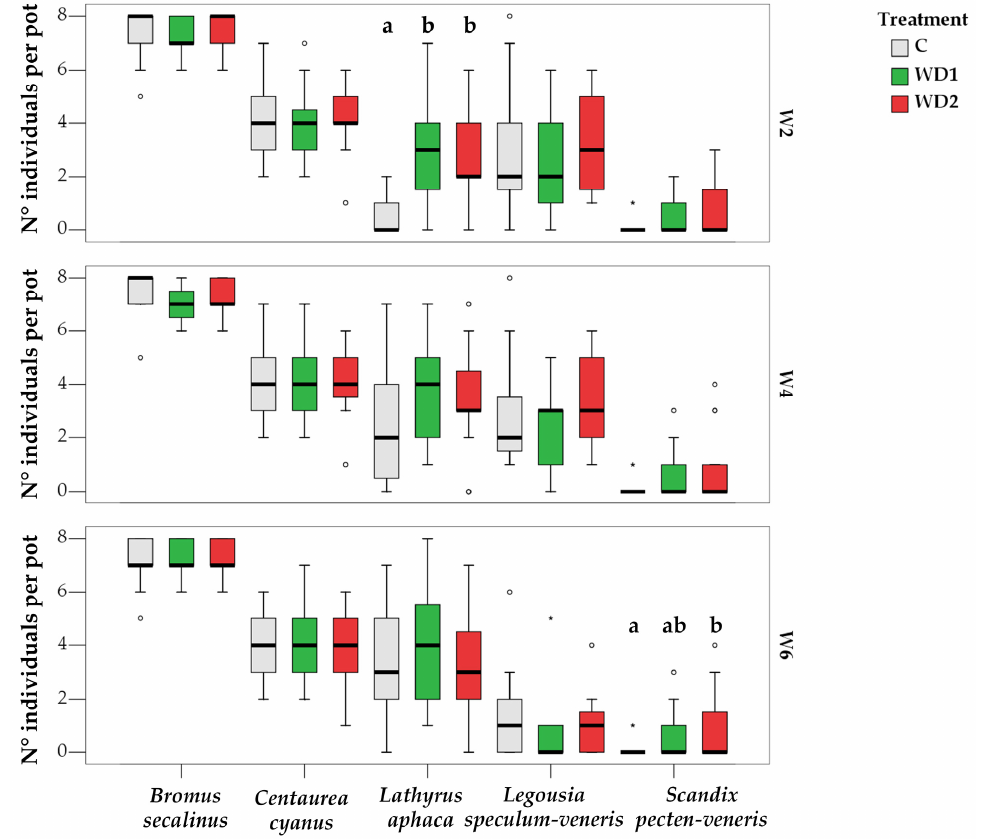
Figure 4. Boxplots showing the total number of individuals of each species per pot per treatment (C = 0% wood distillate; WD1 = 0.2% wood distillate; WD2 = 0.5% wood distillate) at week 2 (W2), week 4 (W4), and week 6 (W6). Different letters indicate statistically significant differences between treatments for each species ( α = 0.05). ◦ = outlier; * = extreme value. Table 3. Results of the PERMANOVA analyses on community composition with the dry weight of each species as an abundance measure, on the total dry weight per pot (TDW), and on the dry weight of single species per